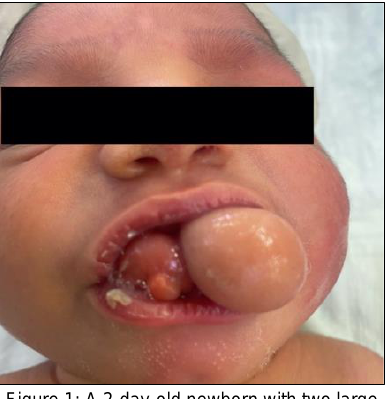
Figure 1: A 2-day-old newborn with two large masses protruding from the oral cavity. On examination, there were no signs of respiratory distress. The patient had no dysmorphic features